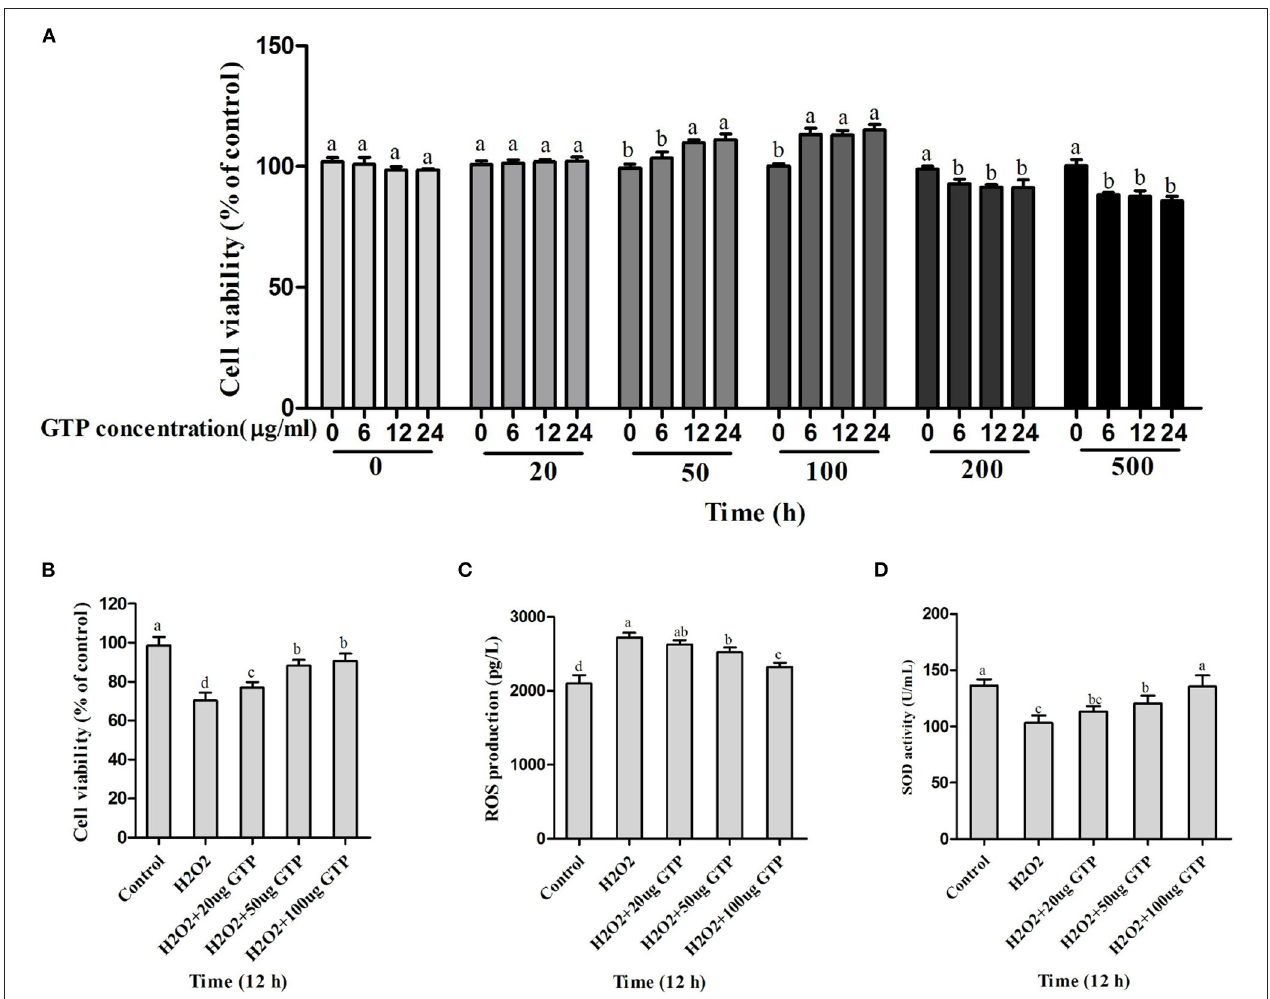
FIGURE 2 | Screening for the safety concentration and time of GTP and optimum concentration of GTP to protect the BMECs. (A,B) Cell viability of BMECs, (C) ROS level in BMECs, and (D) SOD activity in BMECs. a,b,c,d, the adjacent lowercase letters indicate significant difference, the alternate lowercase letters indicate extremely significant difference, and the same lowercase letters indicate insignificant